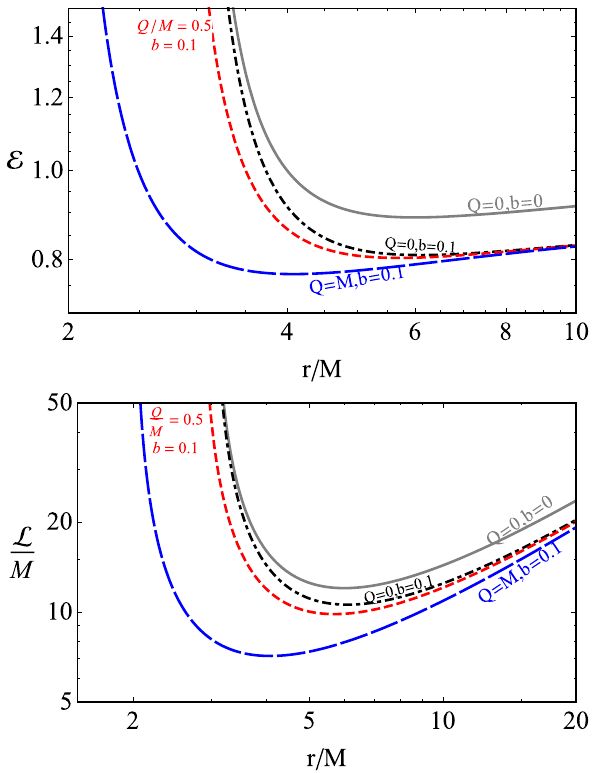
Fig. 2 The radial dependence of the specific energy (top panel) and angular momentum (bottom) corresponding to circular orbits for mag- netized particles around the electrically charged RN black hole for the different values of the electric charge of the black hole and the magnetic coupling parameter b .